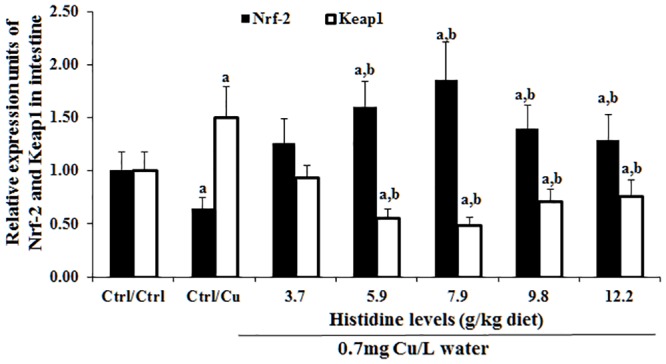
Cu induces increases in Nrf2 and Keap1 mRNA levels in the entire intestine of grass carp. The protocol and indications are shown in Fig 3.Nrf2, NF-E2-related factor-2; Keap1, Kelch-like-ECH-associated protein.